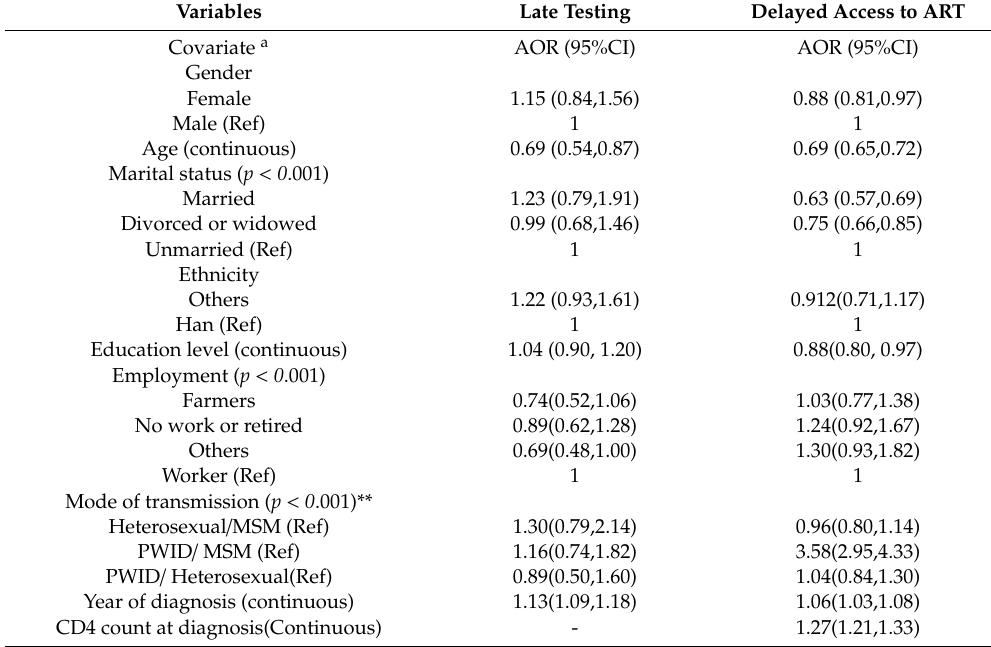
Table 4. Multiple regression analysis of late testing and delayed access to antiretroviral therapy (ART).